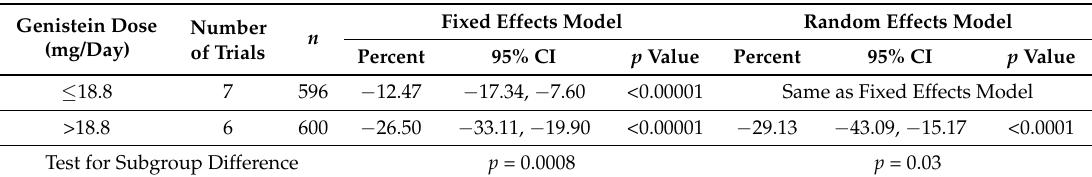
Table 5. Effects of isoflavones on the decrease in hot flash frequency according to the genistein content of the supplement 1